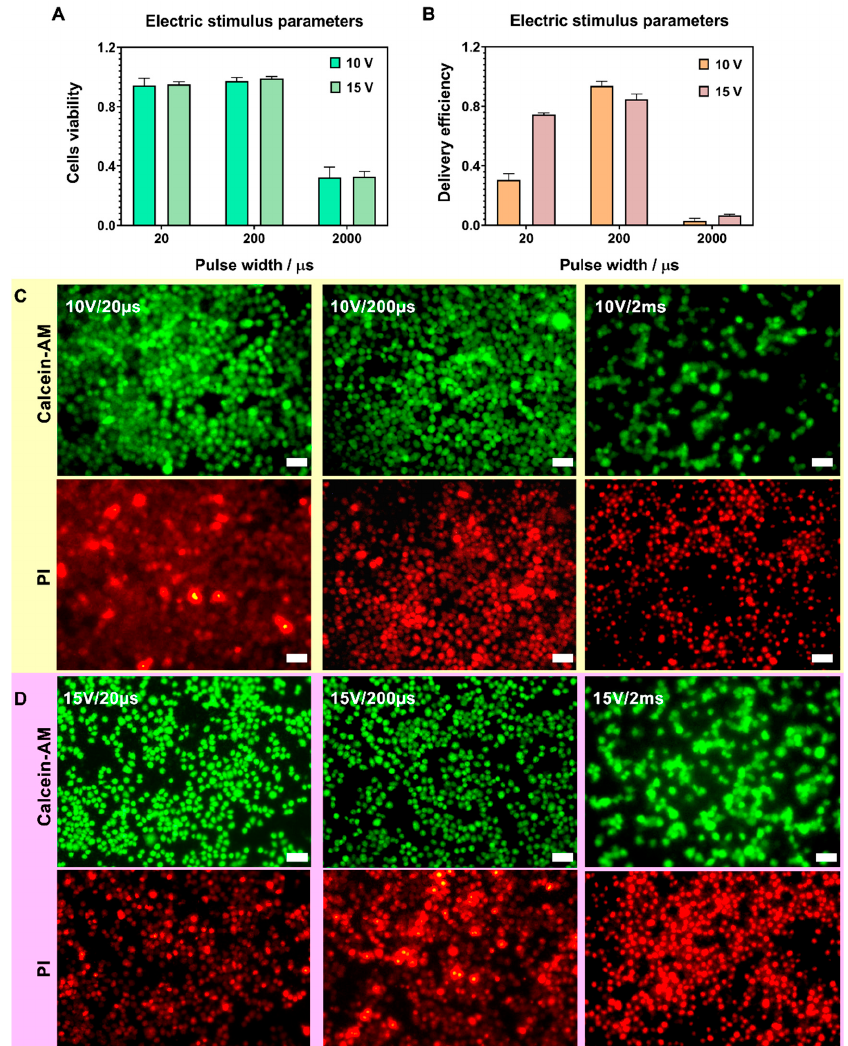
( B ) under four group of nanostraw-electroporation parameters ( n = 3). The nanostraw-electroporation parameters were divided into four groups based on different potentials and electroporation durations. The first one was 5 V group with parameters of 5 V/3 s, 5 V/10 s, 5 V/30 s and 5 V/90 s. the second was 10 V group, included, 10 V/3 s, 10 V/10 s, 10 V/30 s and 10 V/90 s. The third 15 V group was 15 V/30 s, 15 V/30 s, 15 V/30 s and 15 V/90 s. The last 20 V group was, 20 V/3 s, 20 V/10 s, 20 V/30 s and 20 V/90 s. ( C – F ), The corresponding cell fluorescence diagrams after nanostraw-electroporation under these four groups of parameters (( C ), 5 V group parameters. ( D ), 10 V group parameters. ( E ), 15 V group parameters. ( F ), 20 V group parameters). Live cells were stained by Calcein-AM (green fluorescence) after electroporation in all groups, and perforated cells were stained by the intracellular PI (red fluorescence), scale bar, 50 µ m.